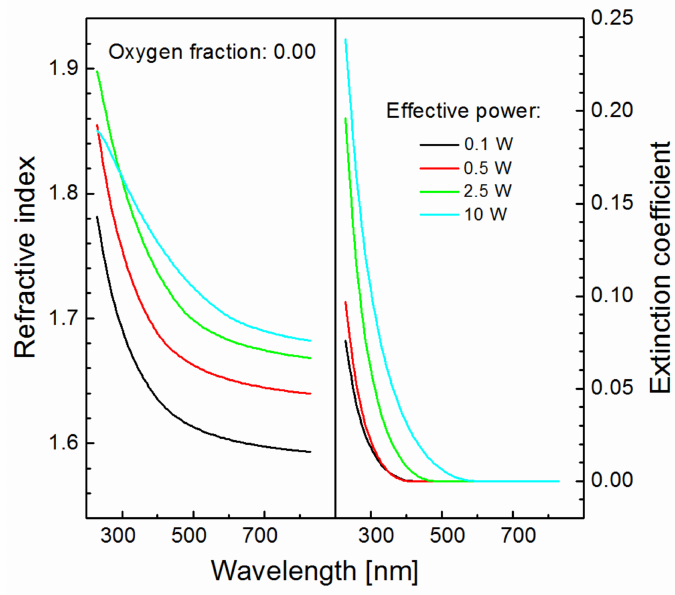
Figure 5. Dispersion curves for the refractive index and the extinction coefficient corresponding to the films deposited from the pure TVS monomer (zero oxygen fraction) at different effective